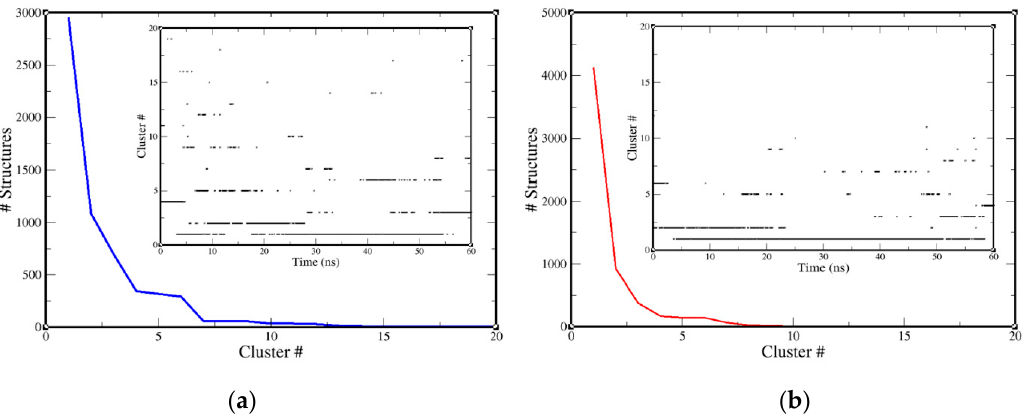
Figure 7. Cluster analysis of ( a ) NuBBE-1970–NSP15 and ( b ) NuBBE-242–NSP15 complexes by taking backbone for calculations. Descending blue and red lines indicate clusters of representation structures with respect to time. Subplots represent generated clusters during simulation. Cluster analysis was approximated using a cut-off of 0.15 nm.